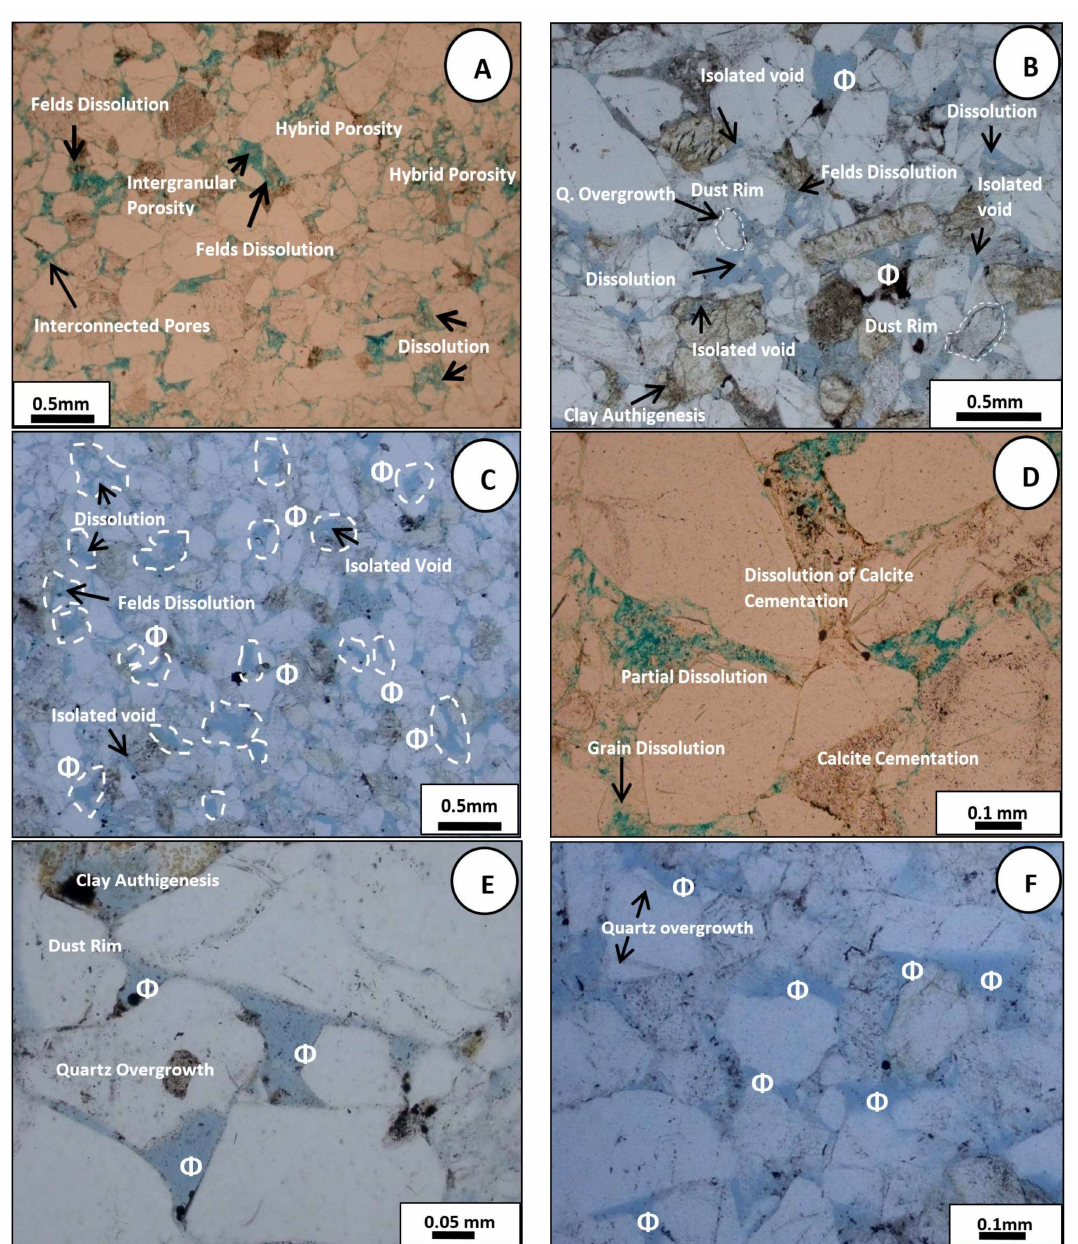
Figure 6. Thin section photomicrographs of medium sized McKee sandstone with porosity-enhancing features under plane-polarized light. ( A ) Well-sorted sandstone with common intergranular porosity with the presence of dissolution creating hybrid porosity in McKee 4 at 2355 m. ( B ) Moderately sorted sandstone with fairly small common intergranular porosity (stained blue) with secondary porosity (isolated pores) in McKee 6A at 2173.25 m. ( C ) Well-sorted sandstone with mostly quartz and feldspar subordinates (stained yellow) with common pores (intergranular pores and grain dissolution pores) in Tuhua-1 at 2256.33 m. ( D ) Secondary porosity by partial dissolution of grains and cement in McKee 4 at 2355 m. ( E ) Intergranular pores (stained blue) with the presence of quartz overgrowth growing from a quartz grain surrounded by dust rim in McKee 6A at 2173.25 m. ( F ) Well-sorted sandstone showing good intergranular porosity with the presence of quartz overgrowth in Tuhua-1 at 2256.3